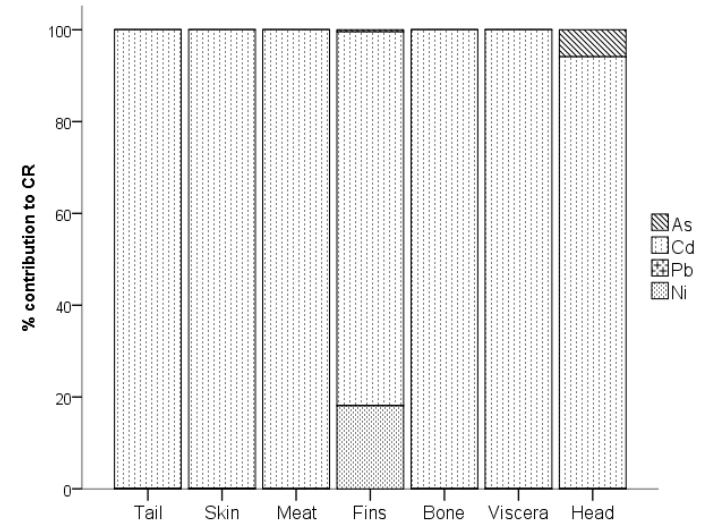
Figure 6. Percent (%) contribution of As, Cd, Pb, and Ni to